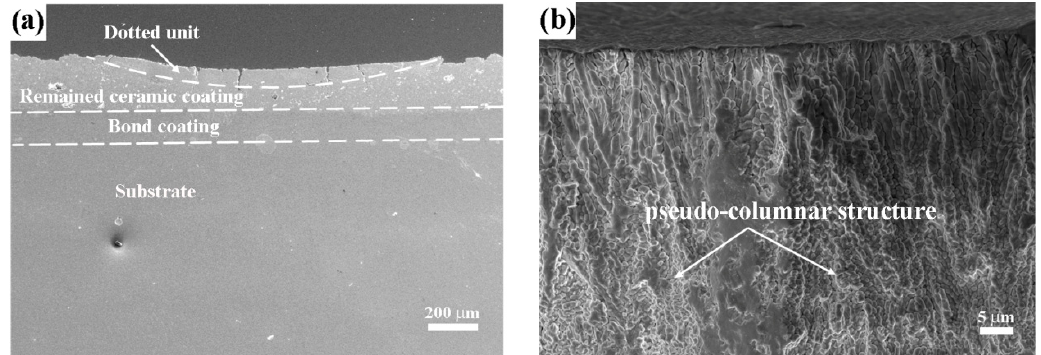
Figure 5. Cross-sectional morphologies of the dotted specimen: ( a ) overview of the dotted unit; ( b ) fracture microstructure of the dotted unit.